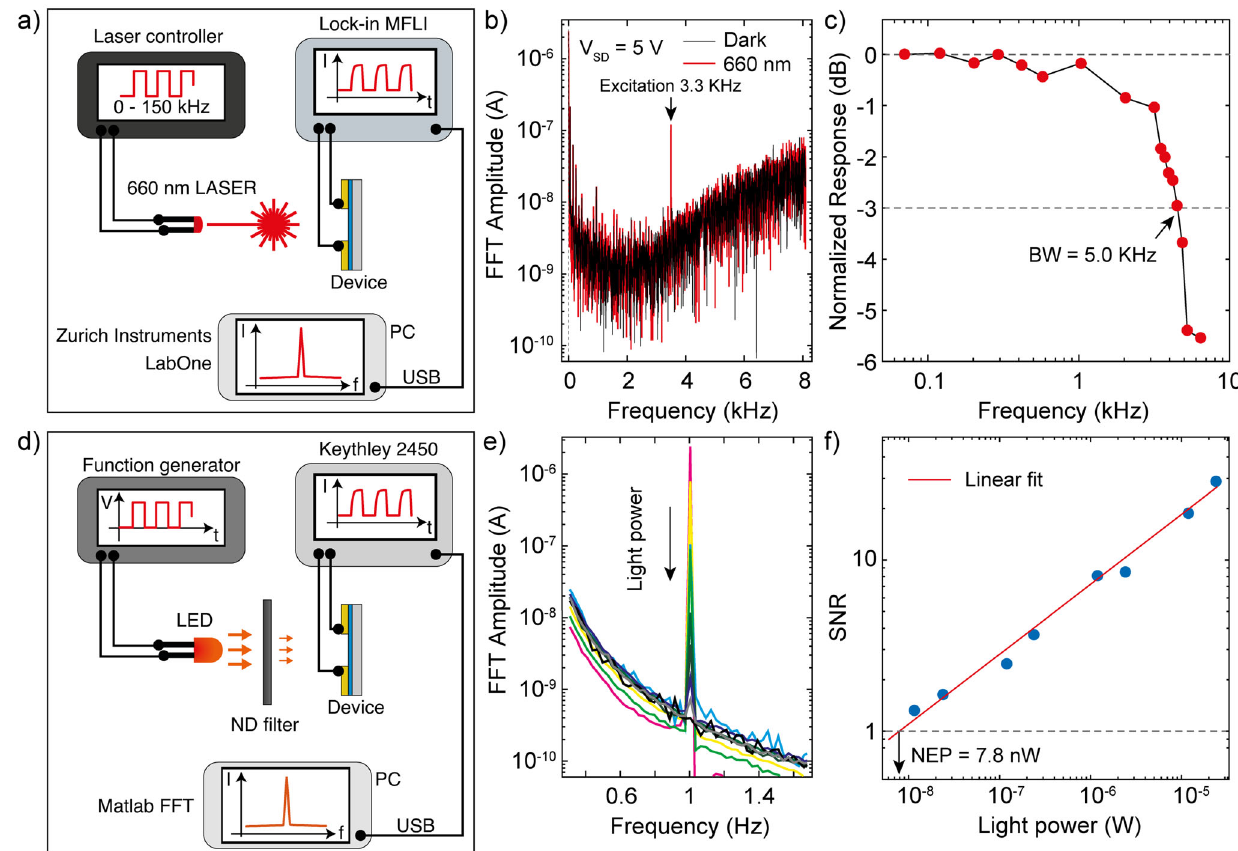
Fig. 4 AC and small signal response of the devices. a Schematic representation of the experimental con fi guration to measure the bandwidth of the device. b Fast Fourier transforms of the current versus time recorded in a WS 2 device in dark (black) and under 660 nm illumination modulated through a 3.3 KHz square wave. The peak at 3.3 KHz corresponds to the response of the device. c Frequency plot of the AC response of the device normalized to the DC response (under continuous illumination) in dB . d Schematic representation of the experimental con fi guration to measure the detectivity of the device. e Fast Fourier transforms of the current versus time recorded in a WS 2 device illuminated with a 660 nm LED modulated at 1 Hz and decreasing illumination powers. f Log – log representation of the signal-to-noise ratio of the 1 Hz peak from panel e versus incident illumination power. The cross between the linear fi t and the SNR = 1 line gives the noise equivalent power